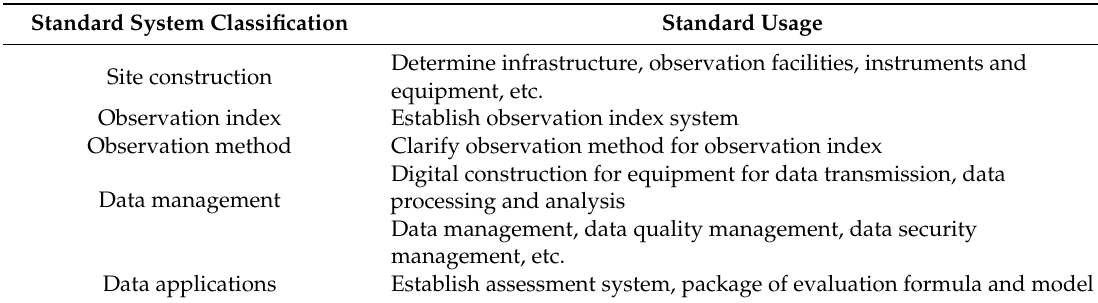
Table 2. Standard system classification used for the